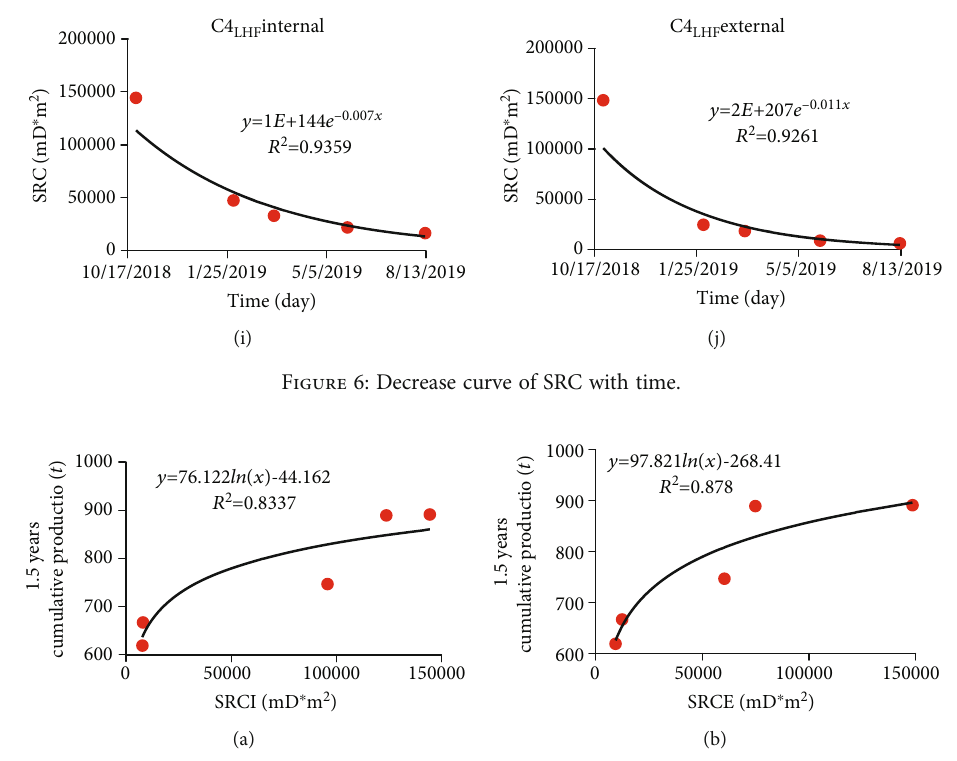
Figure 7: The relationship between the fi rst stage SRC and the 1.5 cumulative